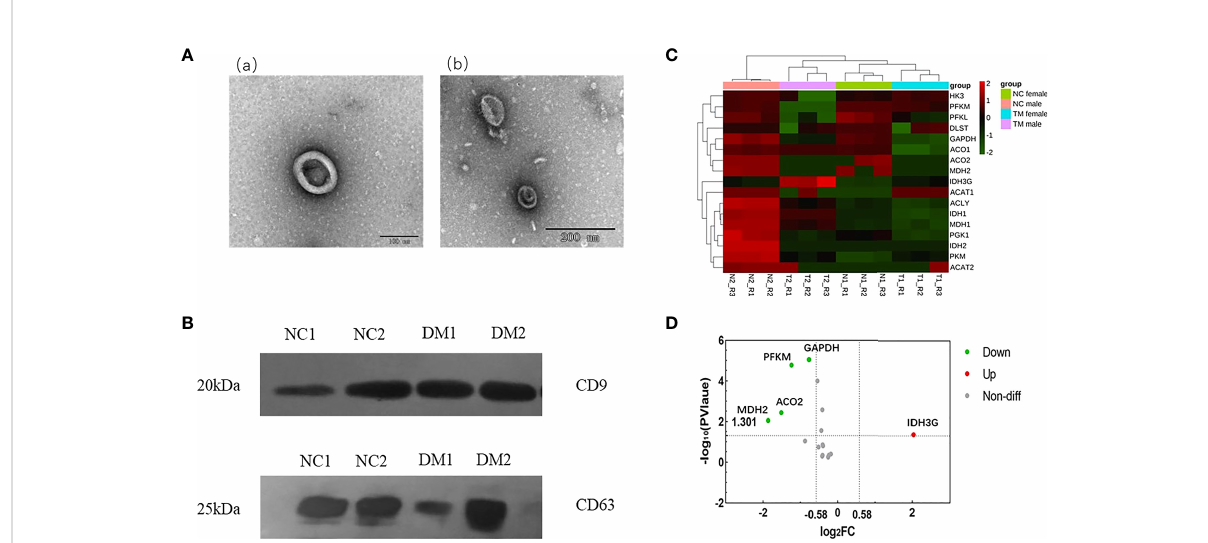
FIGURE 1 Identi fi cation of urinary exosomes and proteomic analysis of enzymes related to aerobic oxidative metabolism. (A) Representative TEM image of urinary exosomes. Exosomes with oval morphology are shown (scale bars; a = 100 nm, b = 200 nm). (B) Western blot images of urinary exosome markers CD9, CD63. Signi fi cant expression of CD9 and CD63 markers could be seen in NC group and DM group. (C) Hierarchical clustering heat map analysis of aerobic oxidative metabolism related proteins in diabetic group (DM) and normal control group (NC). N1, female in NC group; N2, male in NC group; T1, female in DM group; T2, male in DM group. (D) Volcano analysis of aerobic oxidative metabolism related proteins in diabetic group (DM) and normal control group (NC).FC, fold change; The abscissa is represented by log2 (FC), the genes with greater differences are distributed at both ends, and the ordinate is represented by -log10 (P